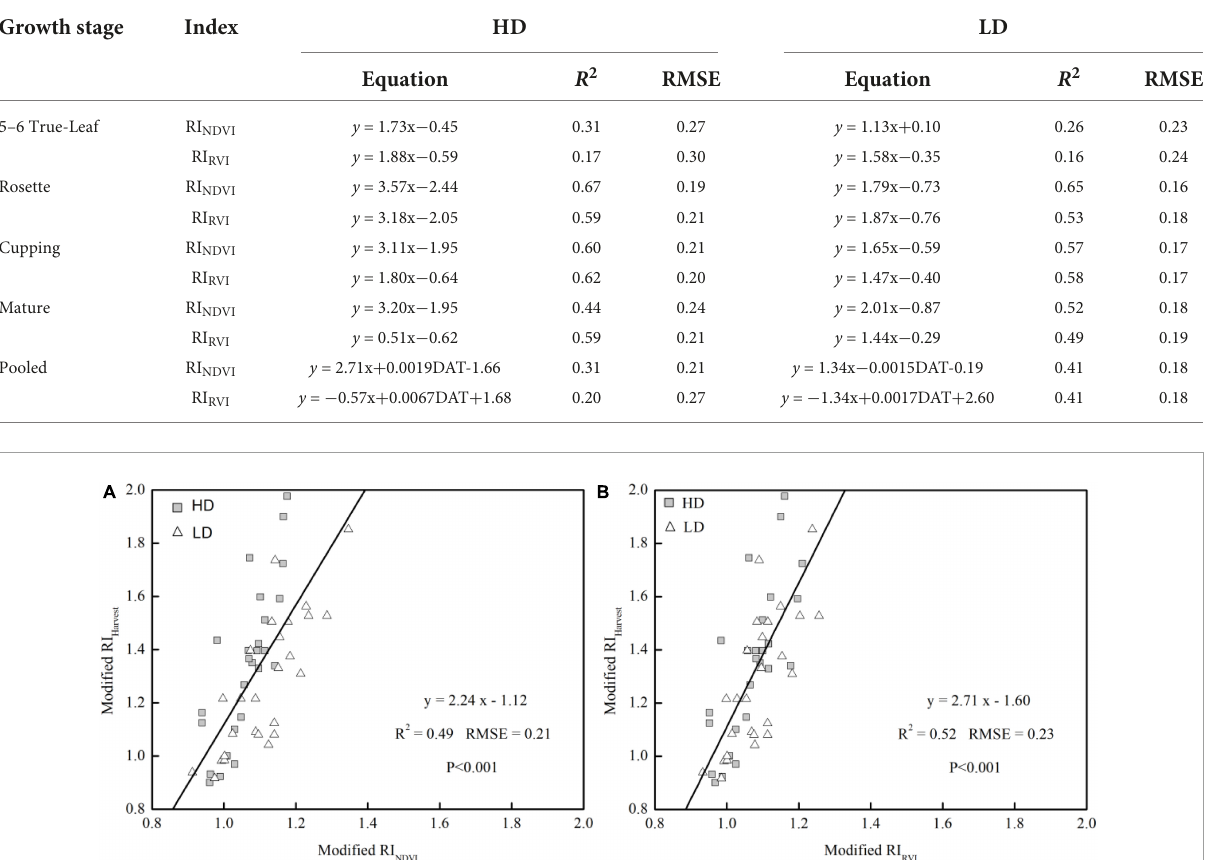
TABLE 4 Relationship between RI NDVI and RI RVI with RI Harvest ( y in the equations) of bok choy across years at different densities of high density (HD) and low density (LD). Growth stage